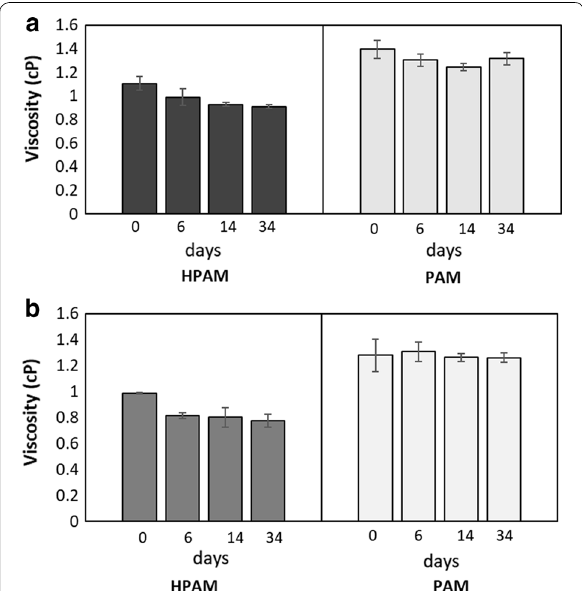
Fig. 3 NH 2 concentrations in a PW and b sludge microbial cultures amended with HPAM or PAM as a N source after 34 days of incubation. Black bars: sterile controls and white bars: actual cultures. Percentage of NH